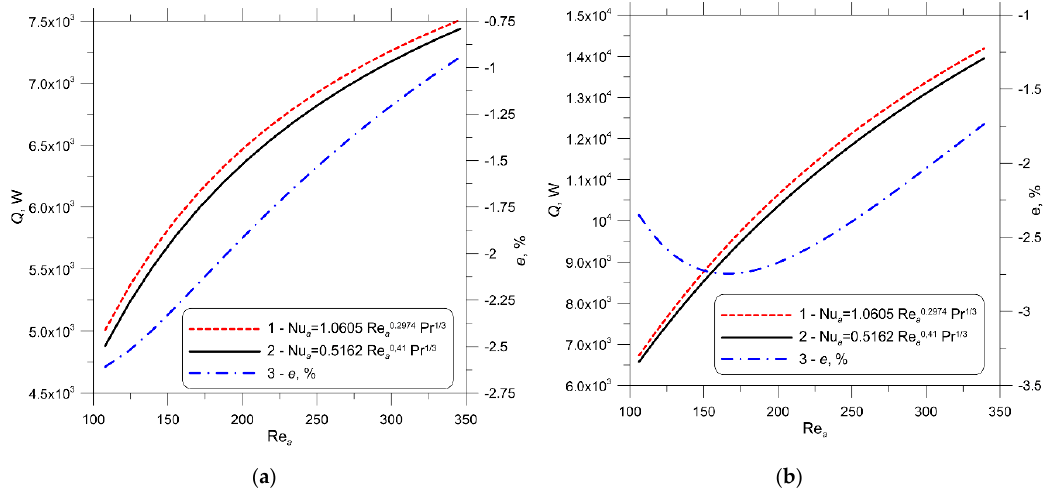
Q from water to air in an engine radiator made of oval tubes Figure 3. The heat transfer rate Figure 3. The heat transfer rate Q t ,1 HTC from water to air in an engine radiator made of oval tubes with ,1 t HTC (cid:48) . = 13.62 ◦ C and h on the air side of the entire radiator; ( a ) V w = 326.06 litres / h, T with an equal HTC an equal HTC h a on the air side of the entire radiator; ( a ) am a (cid:48) (cid:48) (cid:48) . = 59.61 ◦ C; ( b ) = 14.28 ◦ C and T = 60.51 ◦ C; 1—air side equation T V w = 1273.37 litres / h, T w am w obtained from the CFD modelling, 2—empirical air side equation for Nu , 3–relative for Nu a a difference e .